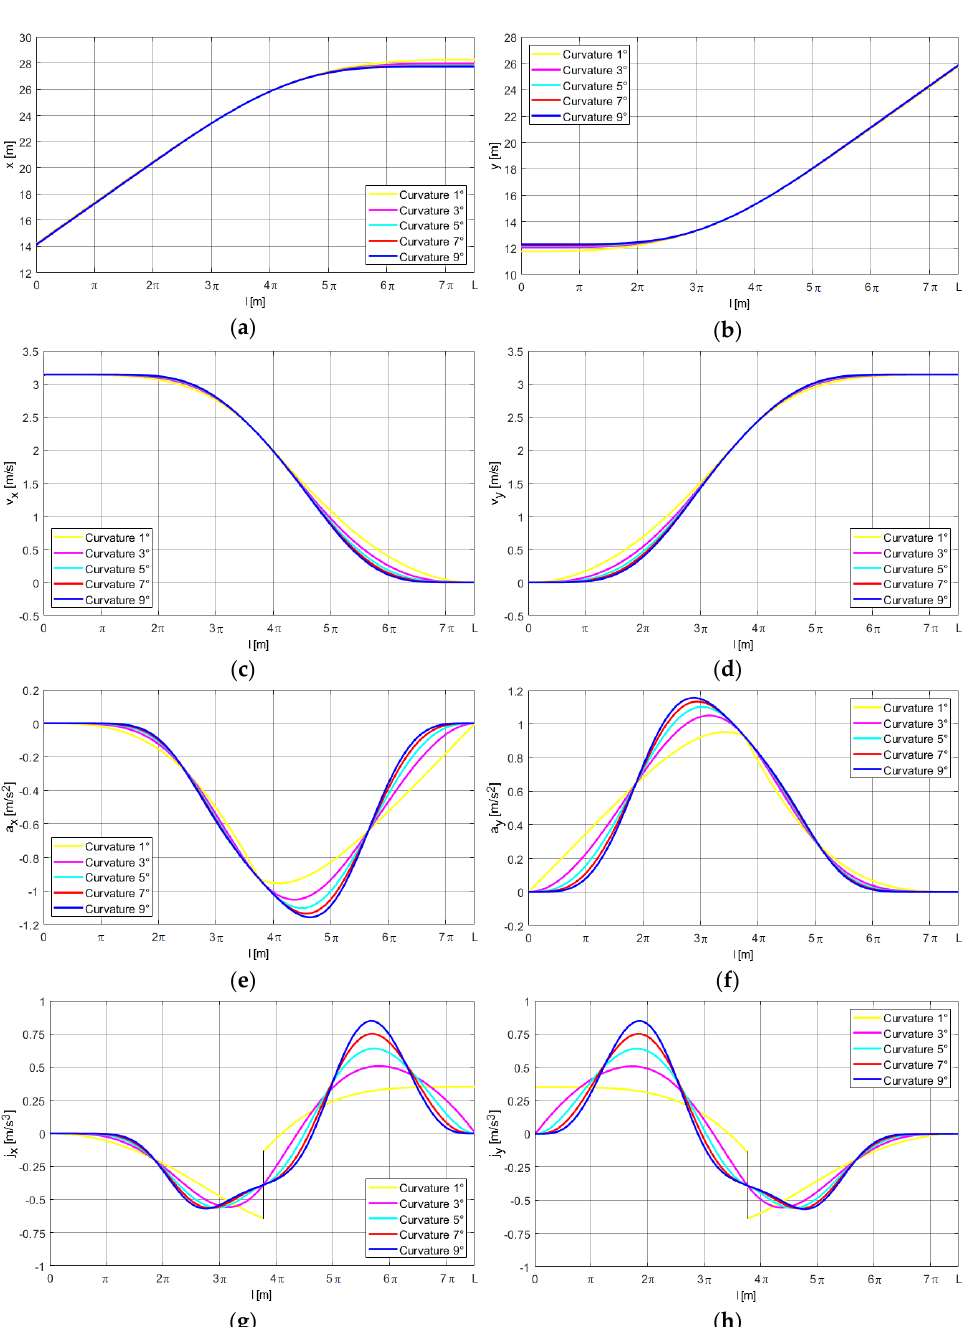
Figure 5. The course of components of kinematic quantities for the HoL trajectory: ( a ) displacement along the axis x; ( b ) displacement along the axis y; ( c ) velocity along the axis x; ( d ) velocity along the axis y; ( e ) acceleration along the axis x; ( f ) acceleration along the axis y; ( g ) jerk along the axis x; ( h ) jerk along the axis y.